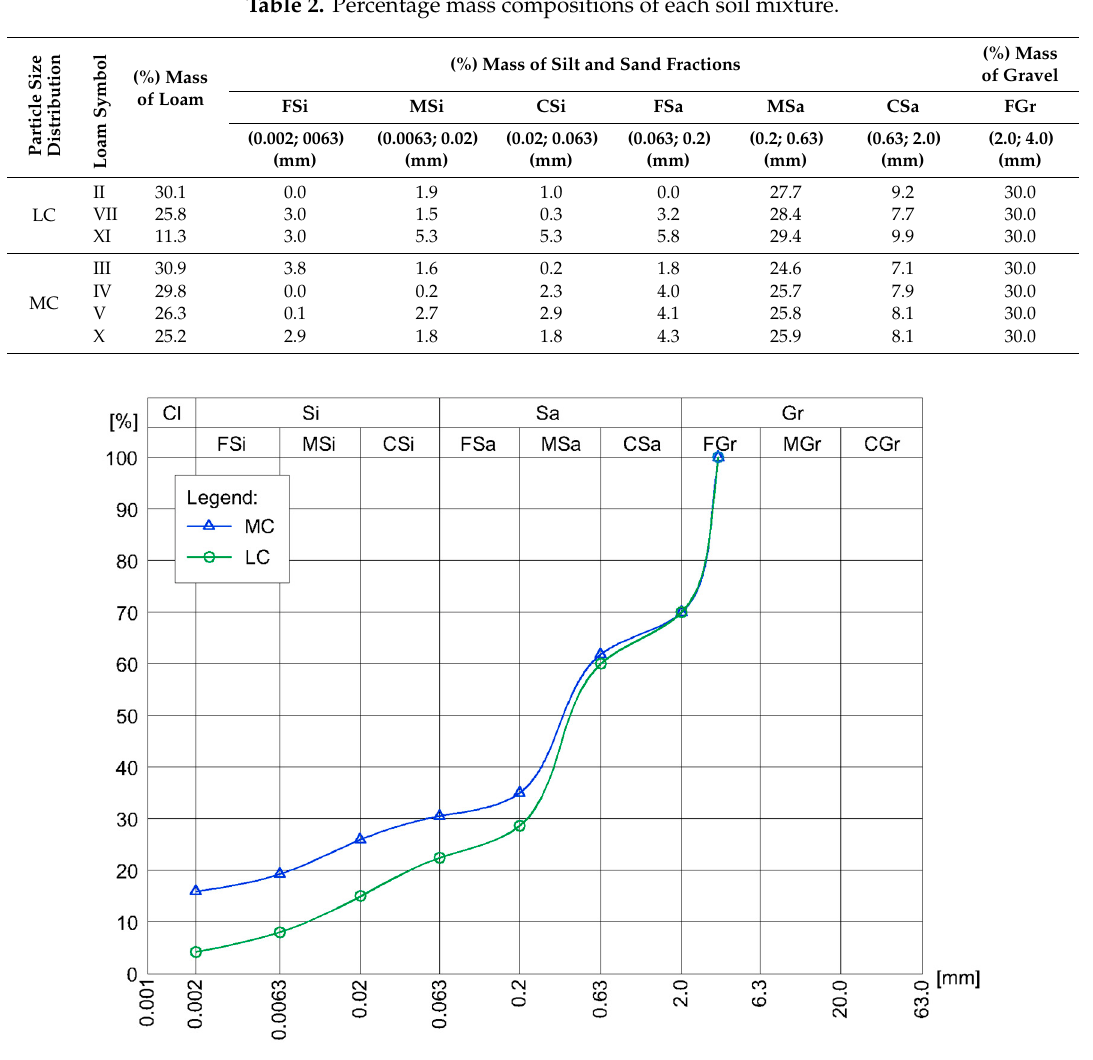
Figure 5. Particle size distribution of soil mixtures used in the CSRE compressive strength tests.